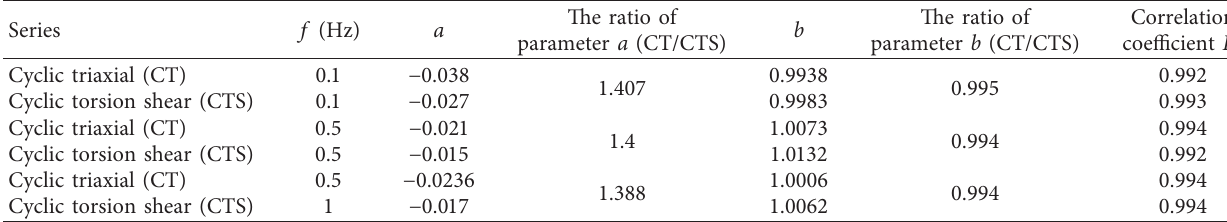
Table 4: Test parameters.